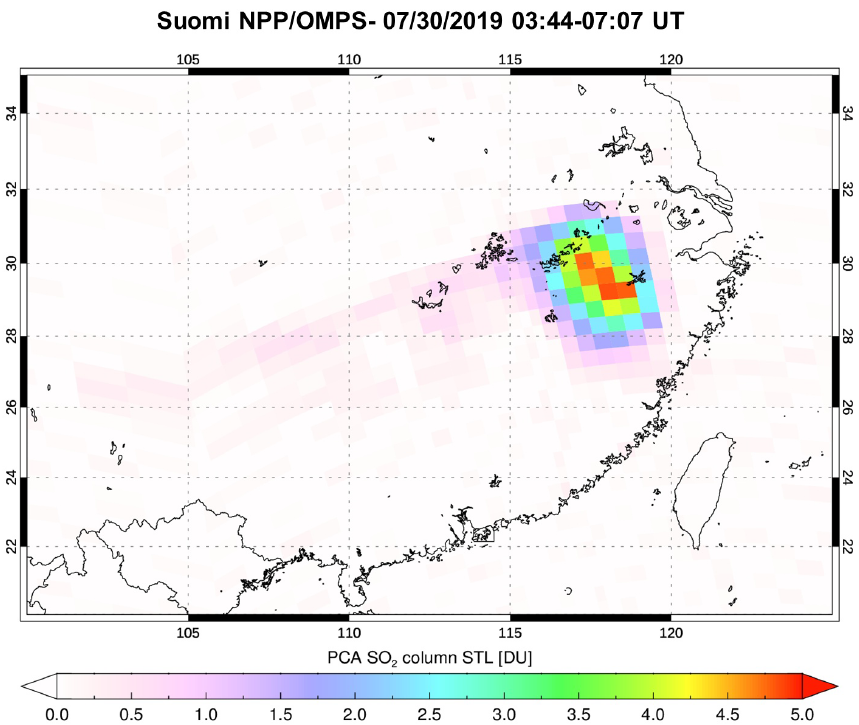
Figure 14. OMPS SO 2 STL columns plotted using a linear scale for 30 July 2019. The data show the westward drift of the CCC with easterly